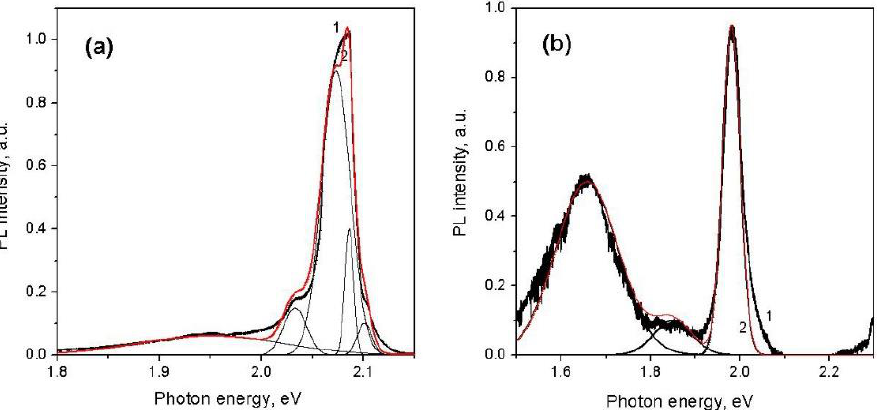
Figure 14. PL spectra for a GaSe crystal with an ARM obtained at an excitation of 532 nm, at 80 K ( a ) and 300 K ( b ). Thick black lines show the experimentally measured PL spectrum, thin black lines show the Gaussian components, and a thick red line shows the sum of these components. Table 2. The result of decomposition into Gaussian components for the PL line in the GaSe Table 3. The result of decomposition into Gaussian components for the PL line in the GaSe crystal with an ARM.